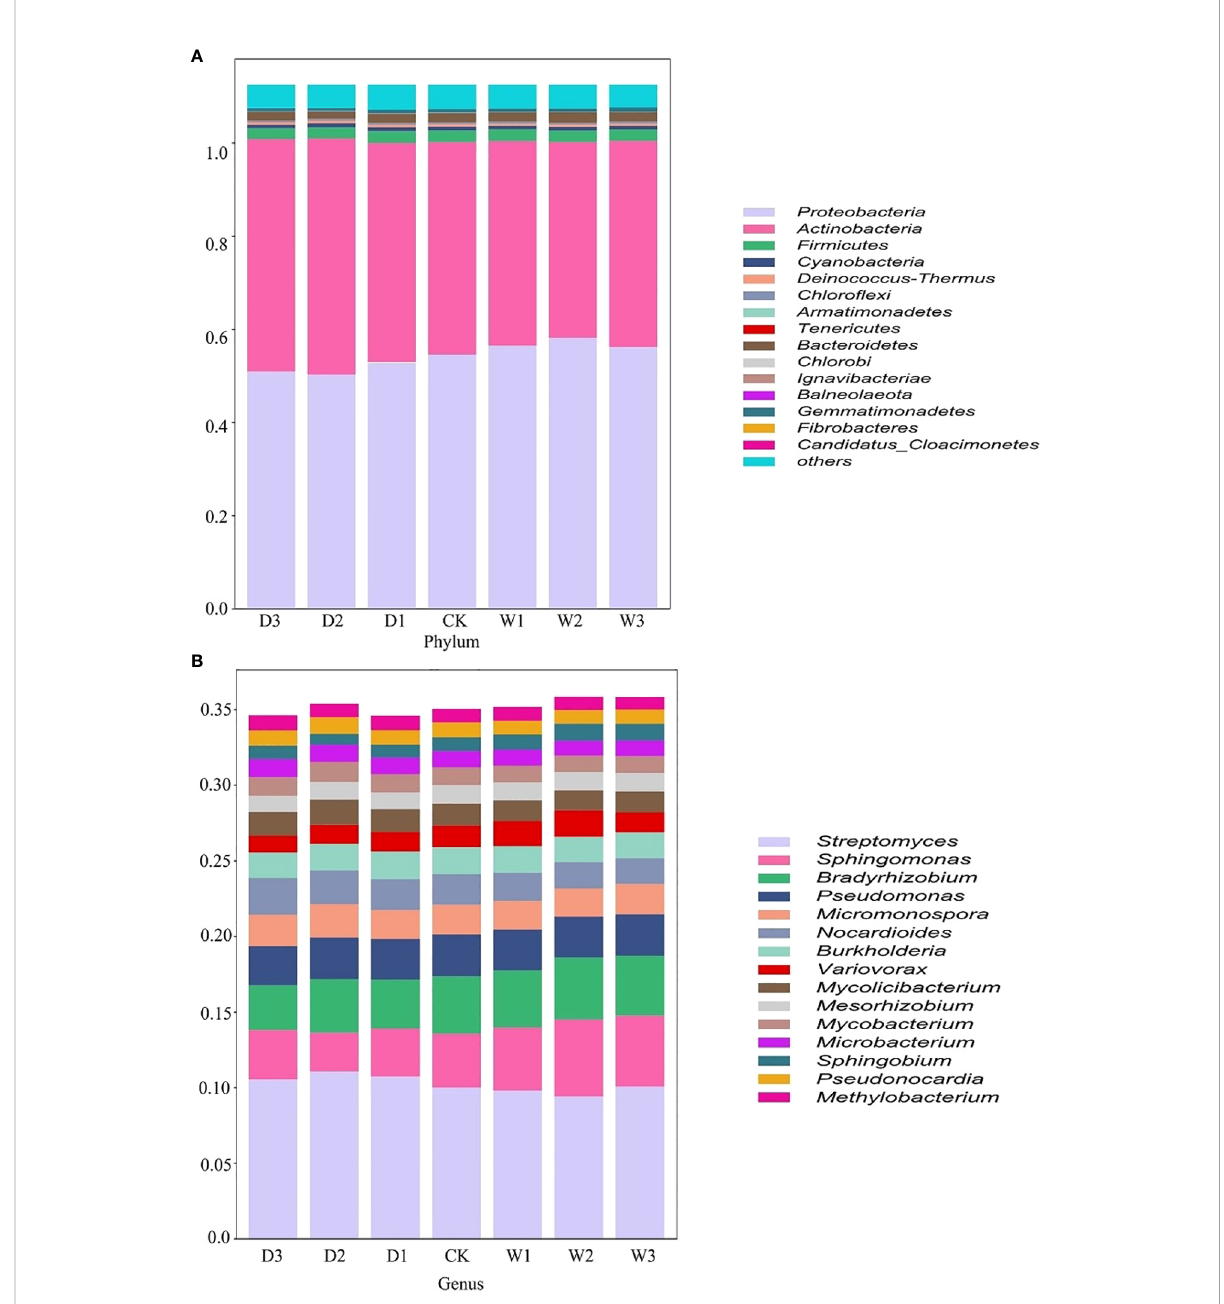
FIGURE 2 Relative abundance of bacteria in different precipitation gradients at the phylum and genus levels on the Northern Tibet. The bacteria whose relative abundance are in the top 15 at phylum (A) and genus (B) levels. D3, water reducing 75%; D3, water reducing 50%; D1, water reducing 25%; CK, control treatment; W1, water increasing 25%; W2, water increasing 50%; W3, water increasing